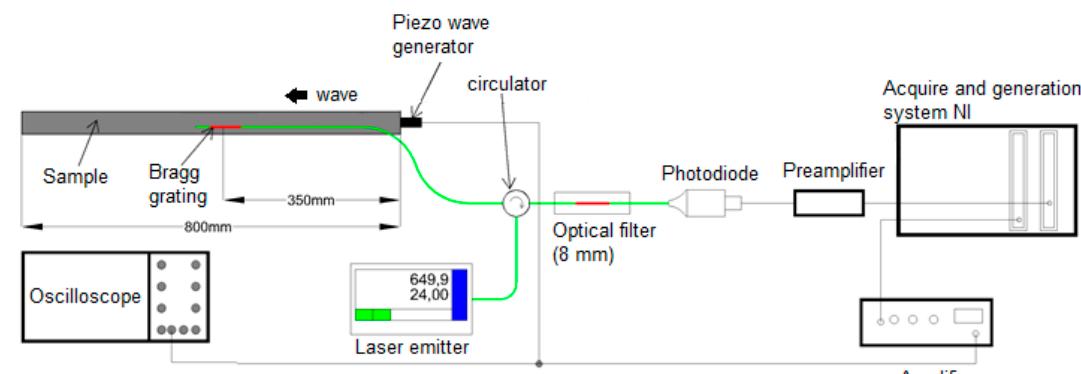
Figure 16. Experimental setup used in the assessment made using optical fiber sensors to capture the propagation of mechanical waves in a rectangular rod.